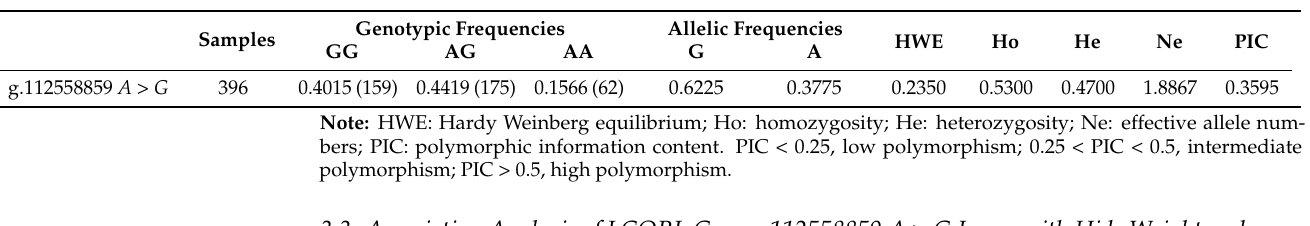
Table 2. Sequence variation frequencies and population indexes for the g.112558859 A > G locus in the LCORL gene of the Dezhou